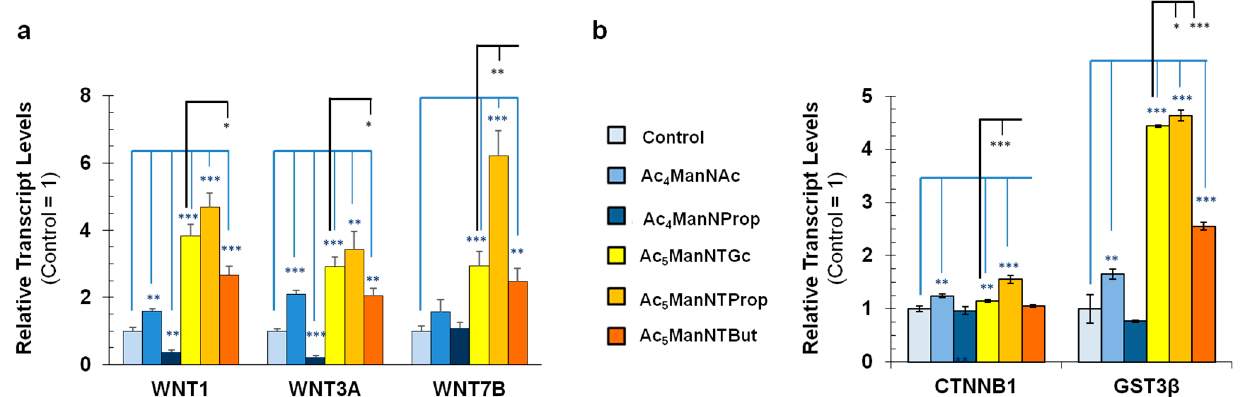
Figure 4. Wnt pathway activation by thiol-modified ManNAc analogs in hNSCs. ( a ) qRT-PCR results showed WNT1, WNT3a, and WNT7b were statistically upregulated more strongly by thiol-modified ManNAc analogs than by sized-matched non-thiolated analogs when compared to the untreated control as indicated by the p values annotated using the blue lines; as shown by the black lines, statistically significant results were also observed for the newly-developed Ac 5 ManNTProp and Ac 5 ManNTBut thio-analogs compared to Ac 5 ManNTGc, our previous thiolated ManNAc analog. ( b ) Transcript analysis of CTNNB1 ( β -catenin) and particularly for GSK3 β showed stronger upregulation by thiol-modified ManNAc analogs compared to their size-matched controls; in addition, statistically significant differences were again observed between the thio-analogs with both β -catenin and GSK3 β most strongly upregulated in Ac 5 ManNTProp-treated hNSCs. (* indicates p < 0.05, ** indicates p < 0.01, *** indicates p < 0.001; if no value is shown, the results were not significantly different).